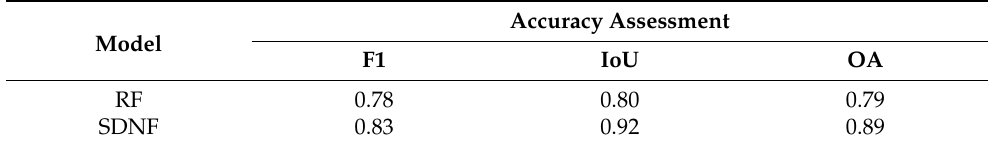
Table 2. Comparison of classification accuracy between SDNF and RF Model.